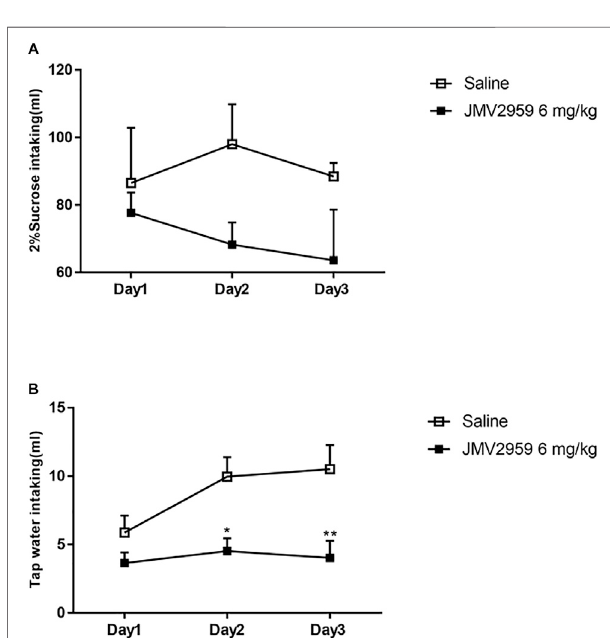
FIGURE 3 | Effect of JMV2959 on natural reward preference. The two- bottle sucrose intake test was performed as described in methods. The difference between Saline group ( n (cid:1) 6) and the group with JMV2959 (6 mg/kg, n (cid:1) 6) were measured by (A) 2% sucrose and (B) tap water intaking up to 3 days. Two-way repeated measures ANOVA was taken. Values are presented as the mean ± SEM ( n (cid:1) 4). * p < 0.05, ** p < 0.01.